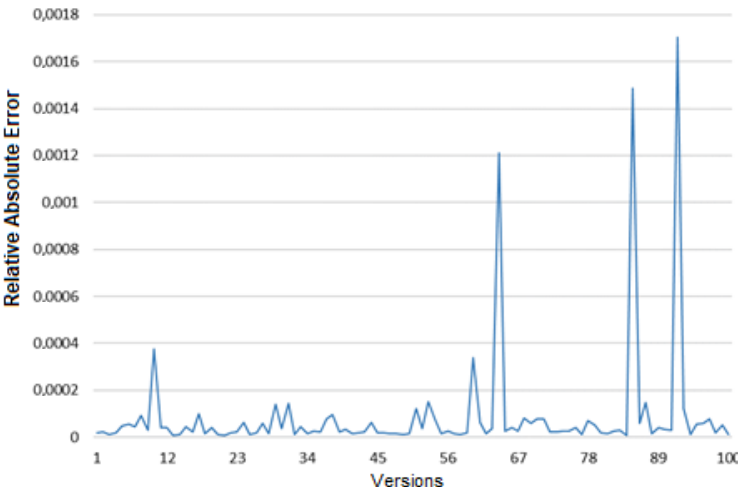
Figure 16. Relative absolute error FEC. Table 5 presents the consolidated results after the 100 simulations using the evolu- tionary algorithms for estimating the DEC and FEC benefits for the reconductoring pro- jects. For the results for the MAPE and MRAE, the minimum errors were well below the errors identified using the current DEC and FEC benefit calculation method (33% for DEC and 50% for FEC). Table 5. Result of the proposed methodology for DEC and FEC. Evolutionary Algorithm